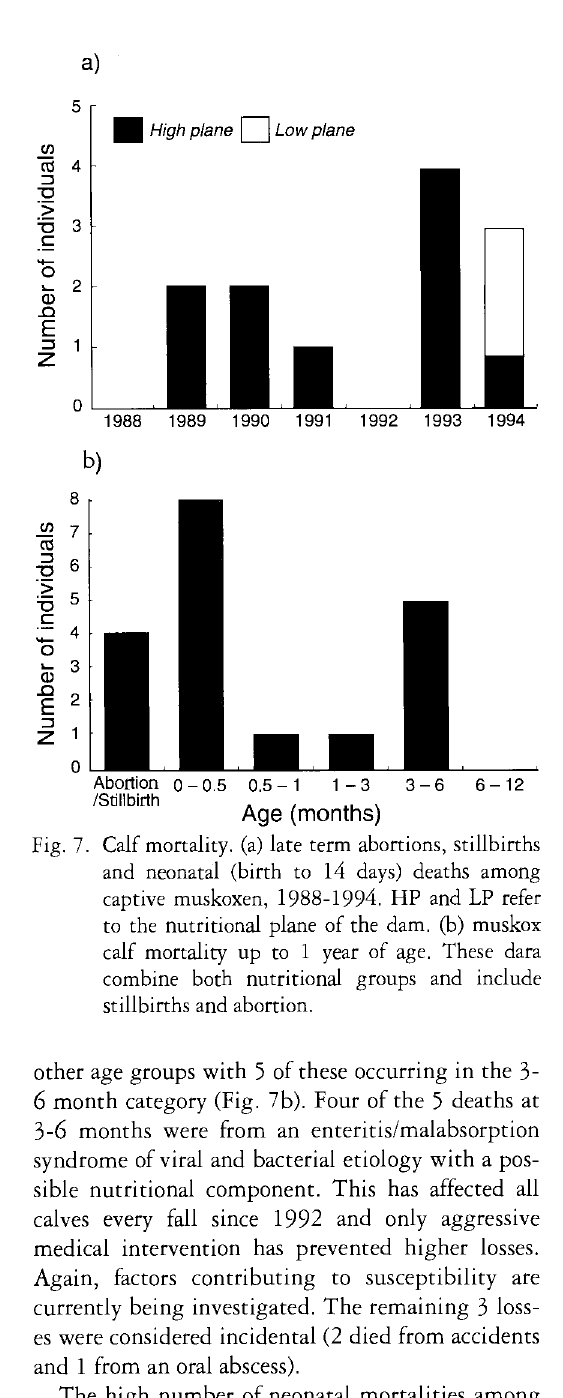
medical intervention has prevented higher